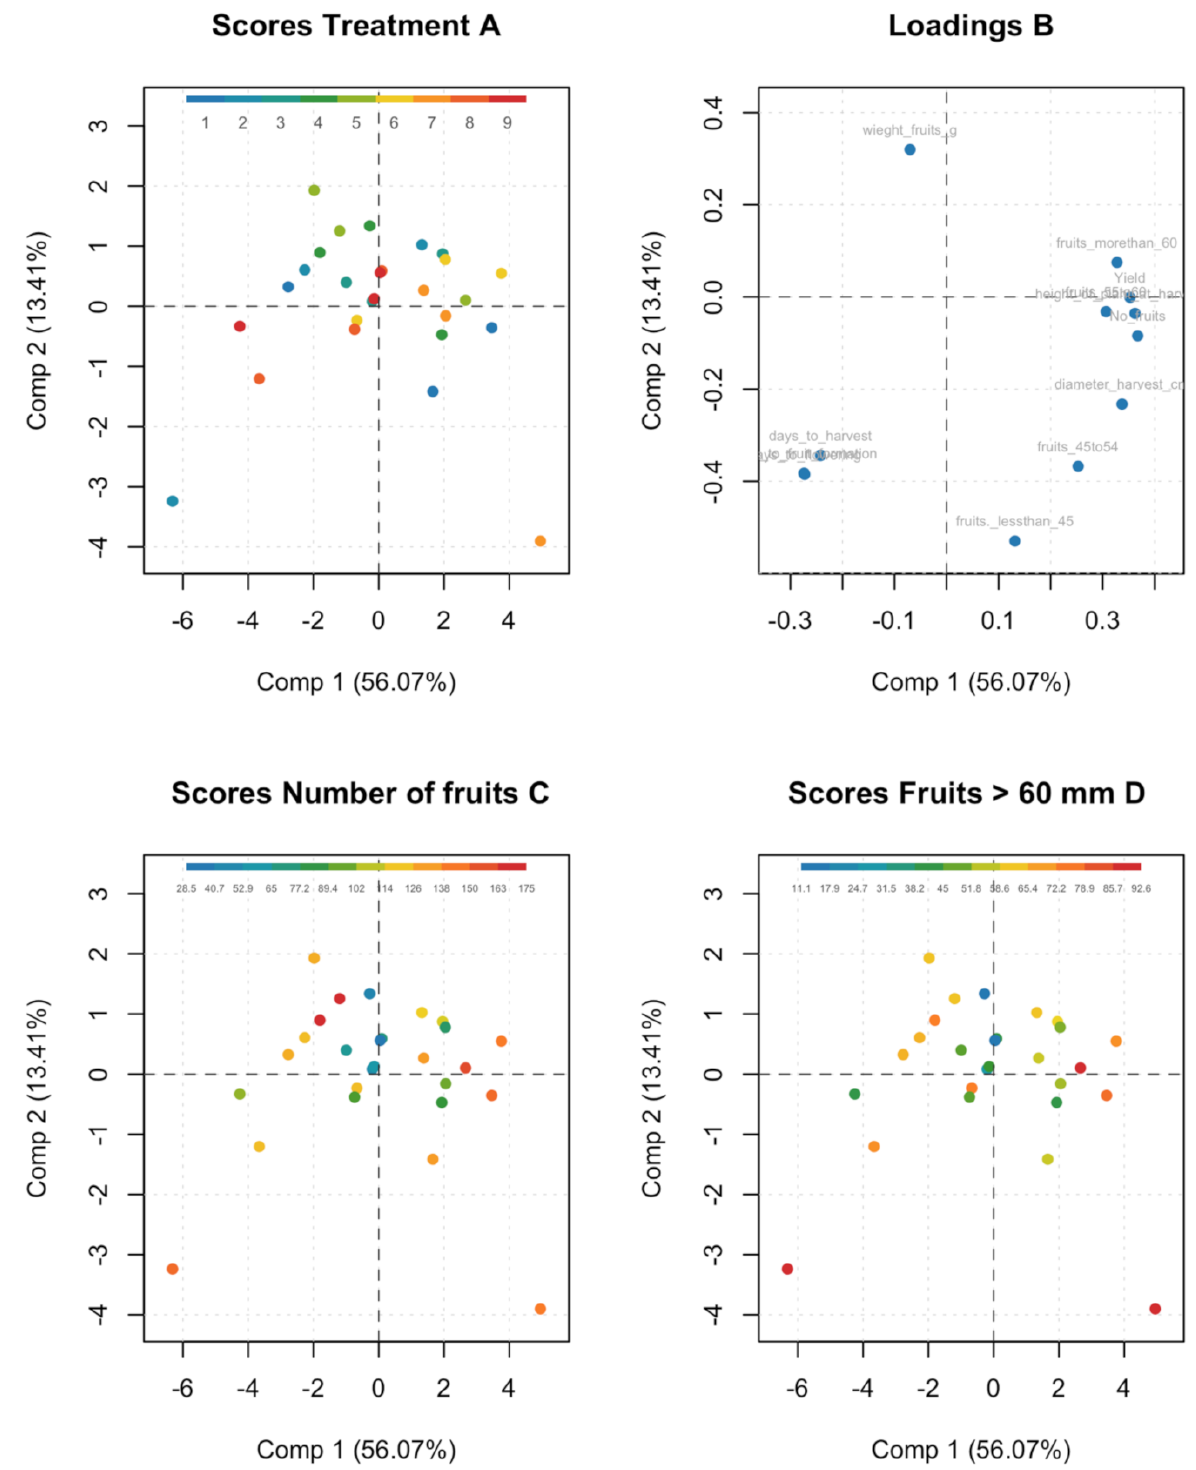
Figure 3. Principal component analysis of naranjilla fruit in the Palora environment. Panel A is the score plot and panel B is the loading plot. Panels C to D provide a representation of the score plot colored with respect to the amount of a given variable (from low to high). Treatments 1 to 9. (1) full treatment with all macronutrients (N, P, K, Ca, Mg, and S), (2) a full treatment without nitrogen ( − N), (3) a full treatment without phosphorus ( − P), (4) a full treatment without potassium ( − K), (5) a full treatment without calcium ( − Ca), (6) a full treatment without magnesium ( − Mg), (7) a full treatment without sulfur ( − S), (8) no nutrients applied plus lime (Control +lime) and (9) no nutrients applied without lime (Control −